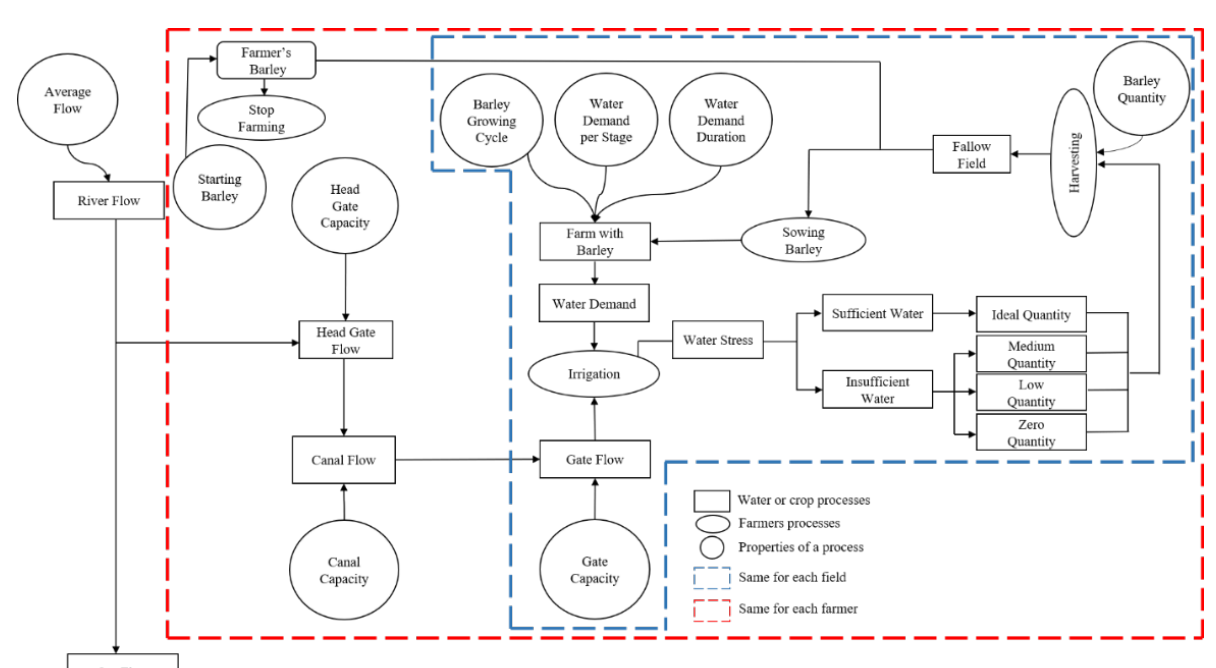
Figure 3. The overview of the model